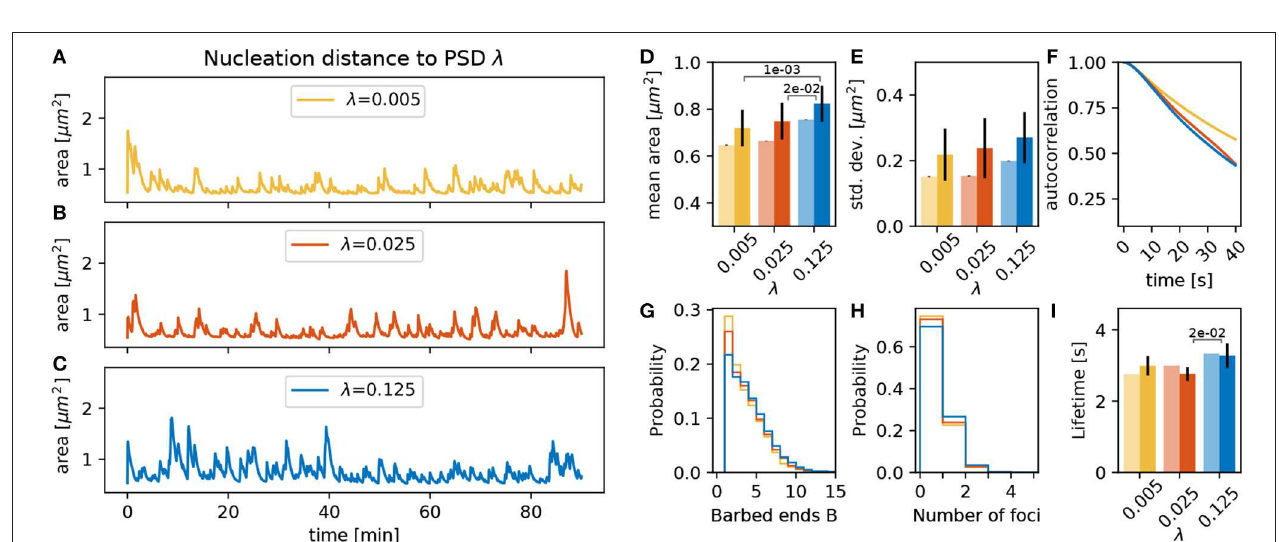
FIGURE 8 | Varying the focus nucleation rate γ f . (A–C) Evolution of the spine head area over time for different values of γ f : (A) γ f γ f 0.125. (D) Temporal mean of the spine head area. Light bars correspond to values from single 90 min simulations (standard deviations obtained from 50-fold = bootstrap). Full colored bars and errors correspond to the mean and standard deviation over fifteen 15 min simulations. The p -value for significant Welch-tests is indicated. (E) Standard deviation of the spine head area over time. (F) Autocorrelation functions for the area fluctuations in the 90 min simulations. (G) Relative frequency of the mean number of barbed ends per focus over all simulation time-steps in (A–C) . (H) Relative frequency of the number of actin polymerization foci. (I) Mean lifetime of a focus.